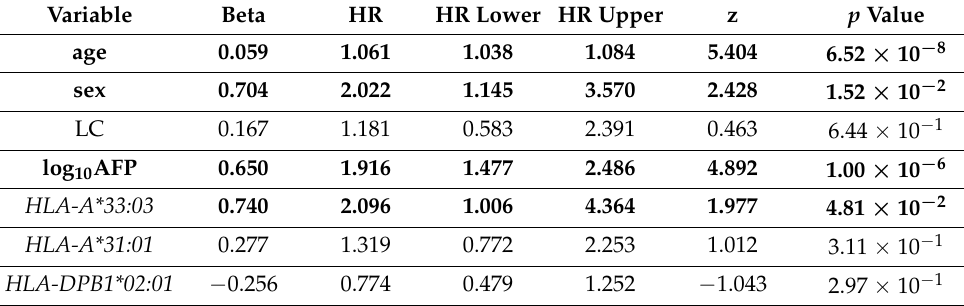
Table 4. Cox proportional hazards model with the initial seven